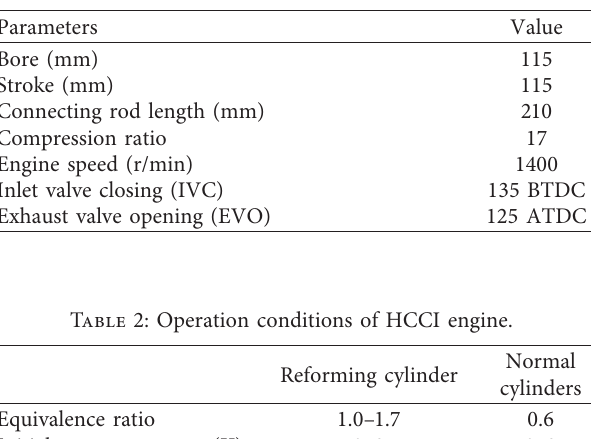
Table 1: Engine specifications.